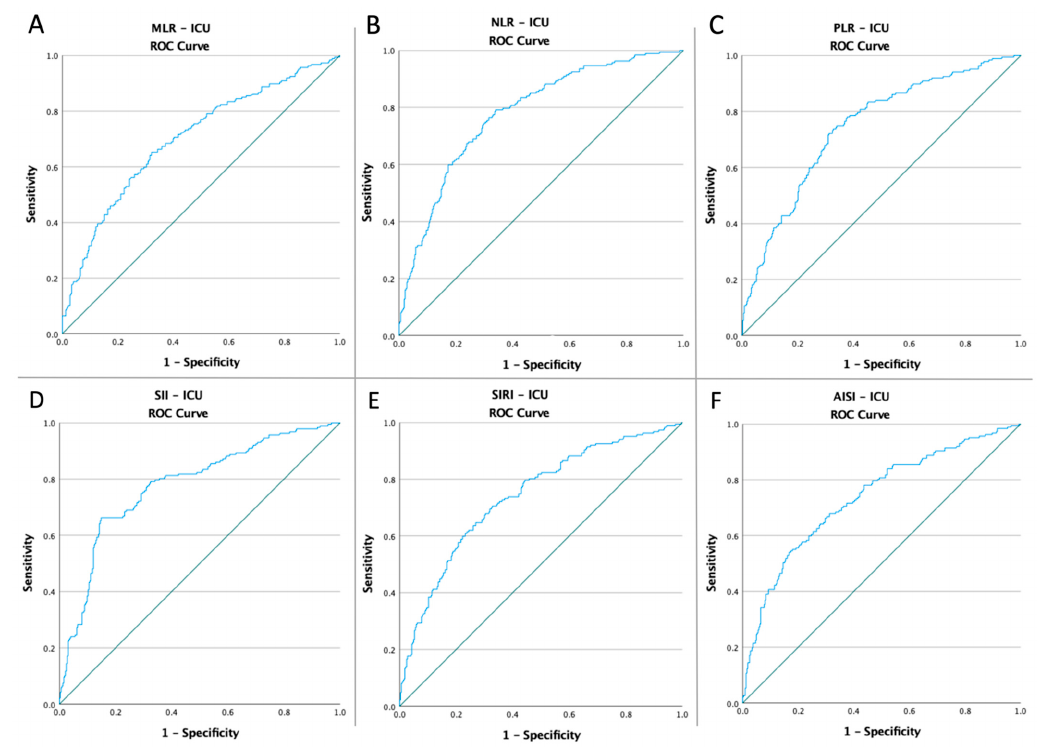
Figure 2. ROC curve analysis concerning ICU admission ( A ) MLR (AUC: 0.829; p < 0.0001), ( B ) NLR (AUC: 0.856; p < 0.0001), ( C ) SII (AUC: 0.858; p < 0.0001), ( D ) SIRI (AUC: 0.785; p < 0.0001), ( E ) AISI (AUC: 0.765; p < 0.0001), and ( F ) TSS (AUC: 0.759; p < 0.0001).